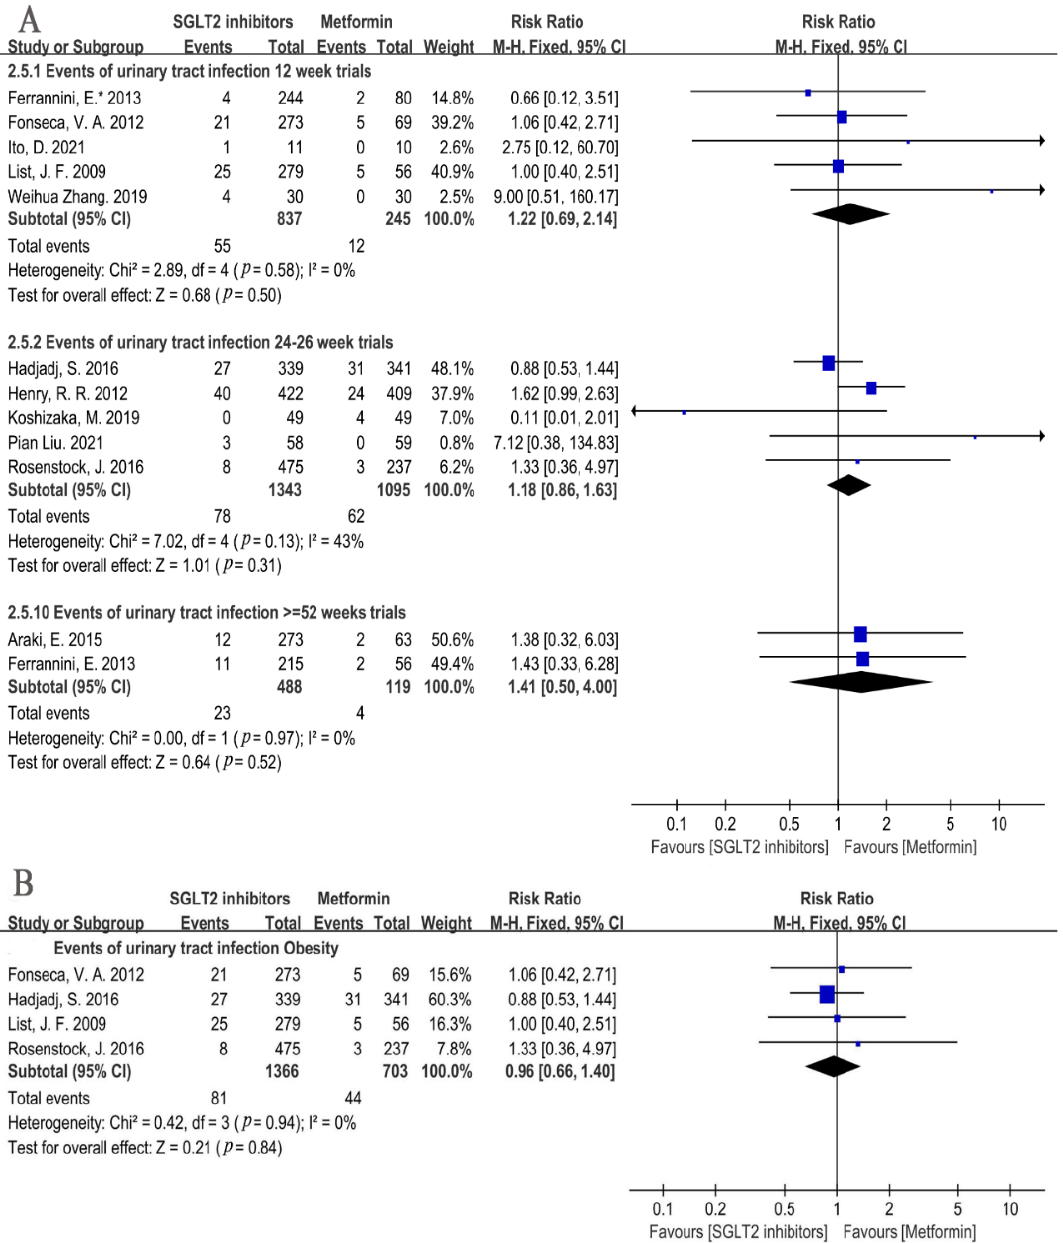
Figure 7. Risk of urinary tract infections with different types and doses of SGLT2i compared with that of metformin in male and female patients [20,22 – 24]. EMPA = empagliflozin.